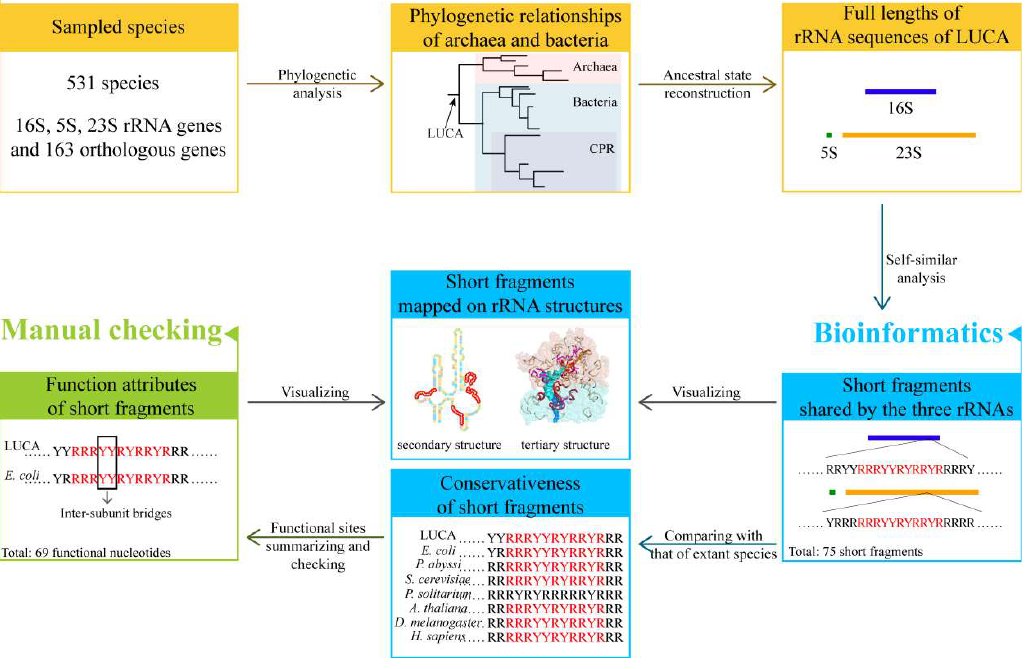
Figure 1. Flow chart overview.